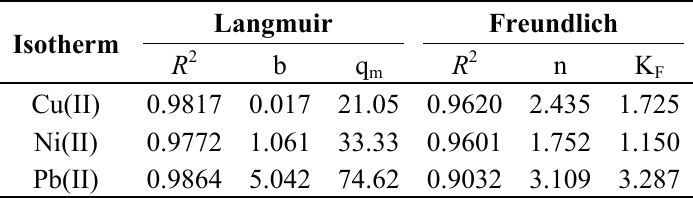
Table 5. Langmuir and Freundlich constant values for the heavy metal ion removal.